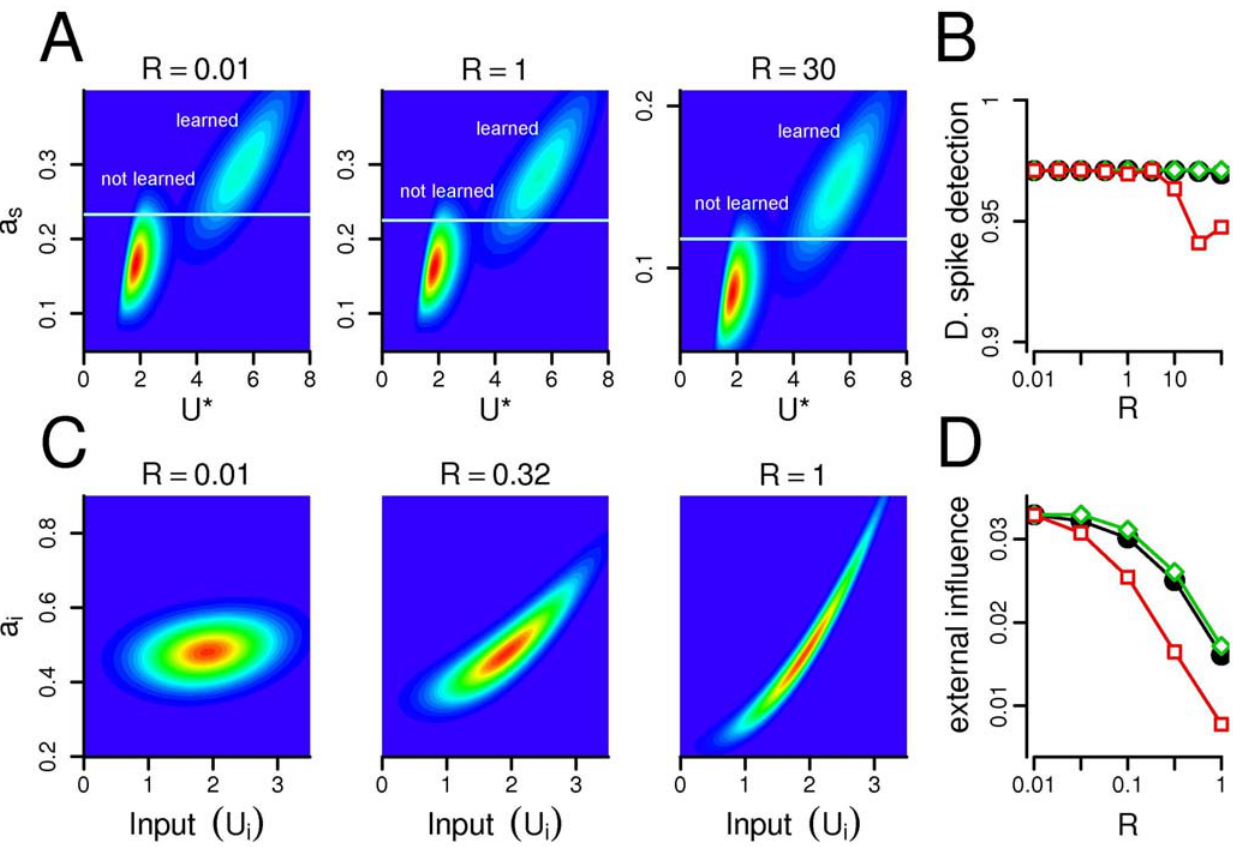
Figure 4. Changing the resistance influence the isolation of compartments, but not the detection of dendritic spikes. (A) The joint distribution of the somatic activation a s and the maximal dendritic input U * with different resistances. (B) The probability of detecting a dendritic spike remains constant even if the resistance changes 2–3 order of magnitude. Black circles: both somatic and dendritic resistances are altered; green ~ 0 : 01 ; red squares: somatic membrane resistance ( R s ) is changed while R s ) is changed, diamonds: only resistance of the dendritic membrane ( R d m m m ~ 0 : 01 . Although the distribution of the somatic activation scales with the resistance (see panel A and Eq. 7), the detection probability of a single R d m dendritic event remains relatively constant. (C) The joint distribution of the activation of a dendritic branch a i and its own input U i . When the resistance is low (left), the local activation depends only slightly on the input. Conversely, if the resistance is higher (right) the local input has substantial impact on the activation of the branch. (D) The external influence decreases as the resistance increases. Symbols are the same as on panel B. Note, that decreasing the resistance of the perisomatic membrane (red squares) is the most efficient in separating the dendritic compartments ). N (recall, that R s ~ R a (cid:1) R s m